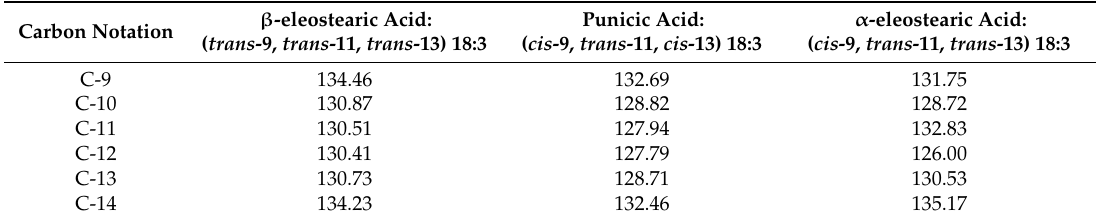
Table 14. 13 C chemical shift values of olefinic carbons of α -eleostearic acid, punicic acid, and β -eleostearic acid (ppm) in CDCl 3 . Reprinted, with permission, from [58].